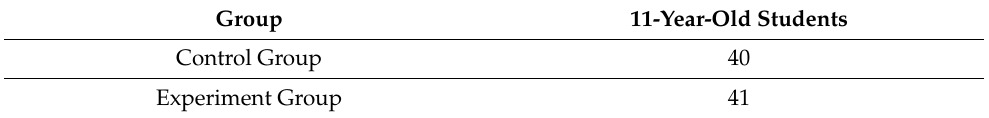
Table 3. Group number in this study.